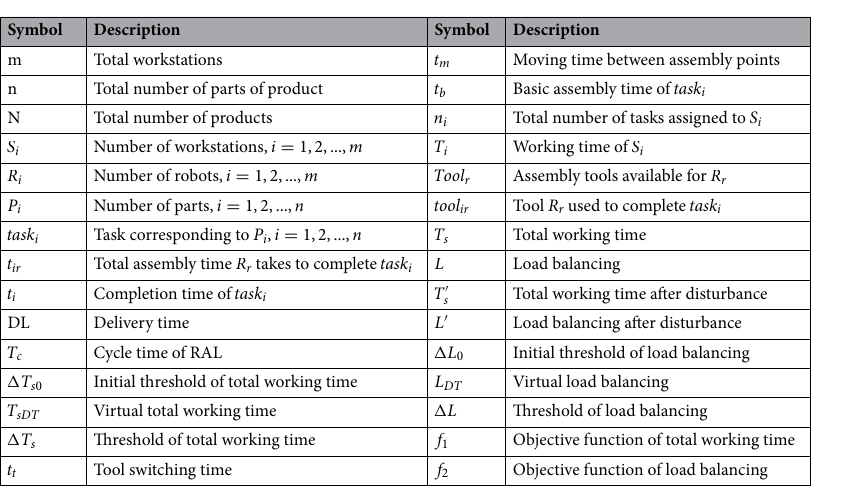
Table 2. List of